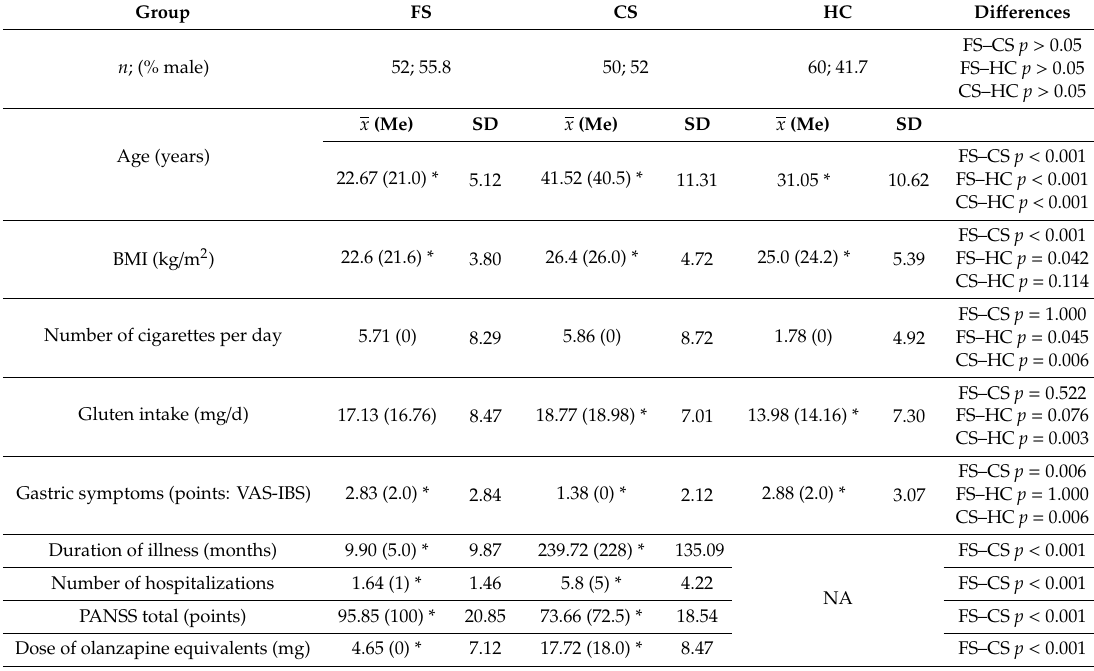
Table 1. Characteristics of